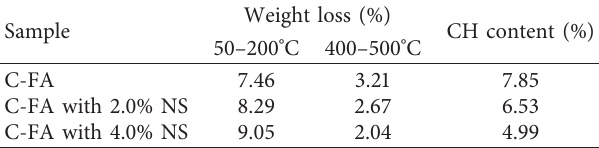
Figure 9: XRD patterns of hydrates. Table 5: Weight loss of paste hydrated for 28d.